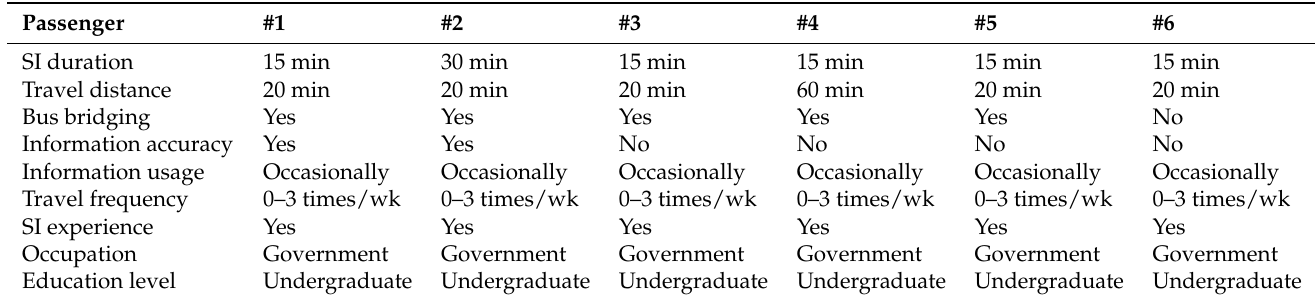
Table 11. Property description of the objects used in the sensitivity